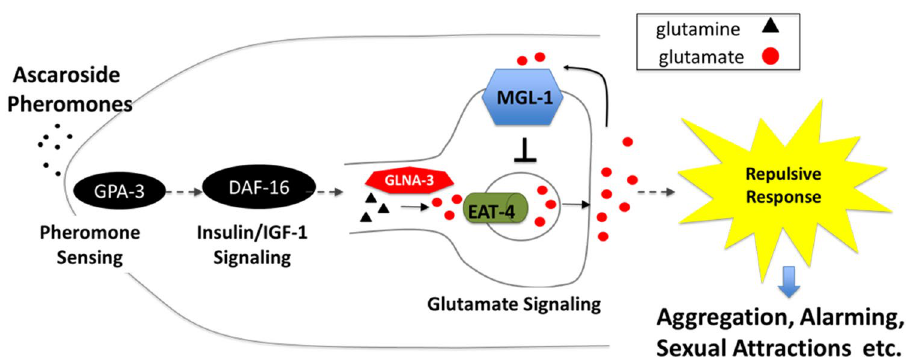
Figure 5. A proposed model of neuronal DAF-16/FoxO-mediated pheromone sensory signal transduction pathway. The pathway from pheromone perception to repulsion behavior includes at least five components: GPA-3, DAF-16/FoxO, GLNA-3, EAT4, and MGL-1. By binding to putative pheromone receptors (not shown), pheromones may stimulate GPA-3 and subsequently activate glutamatergic neurotransmission in AWB neurons, which is transcriptionally modulated by neuronal DAF-16/FoxO via GLNA-3 activation. The production of glutamate signals is likely gated by MGL-1/mGRM3.–unconfirmed relation; ─ confirmed